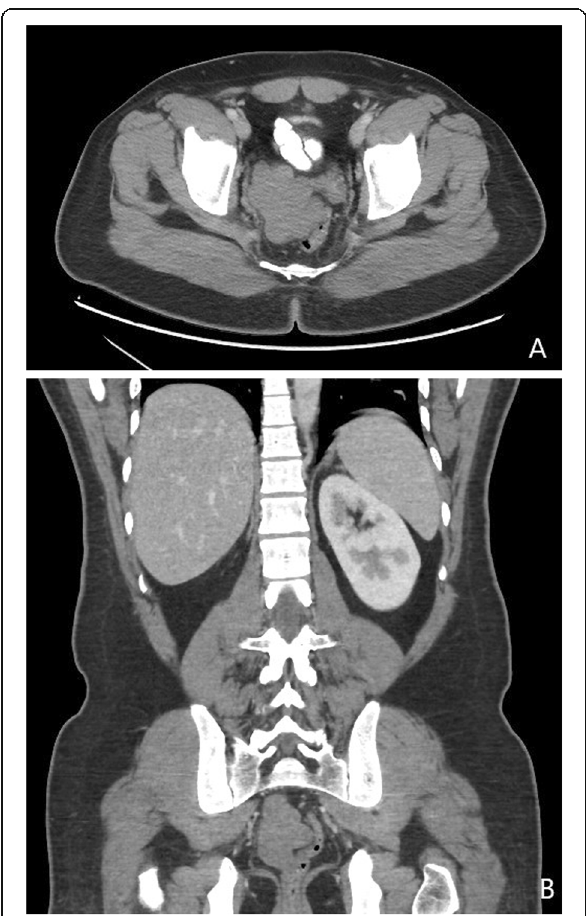
Fig. 2 Post-IV contrast axial ( a ) and coronal ( b ) CT images. The upper abdomen shows single left kidney with absent right kidney. Images in the pelvis showed a lobulated non-enhancing cystic lesion replacing the right seminal vesicle, inseparable from the right upper surface of the prostate and exerting mass effect upon the surrounding structures, upon which MRI was requested